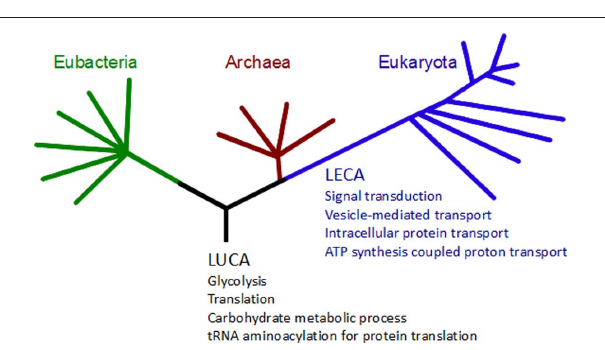
Figure 4 | gene ontology (gO) expansions and innovations associated with conserved protein domains. Protein domains conserved between human and tested species were used to determine associated GO terms (see Materials and Methods). GO terms shown in black are associated with protein domains conserved in eukaryote, archaeal, and bacterial species. GO terms shown in blue are associated with Pfam domains not shared between humans and any archaeal or bacterial species